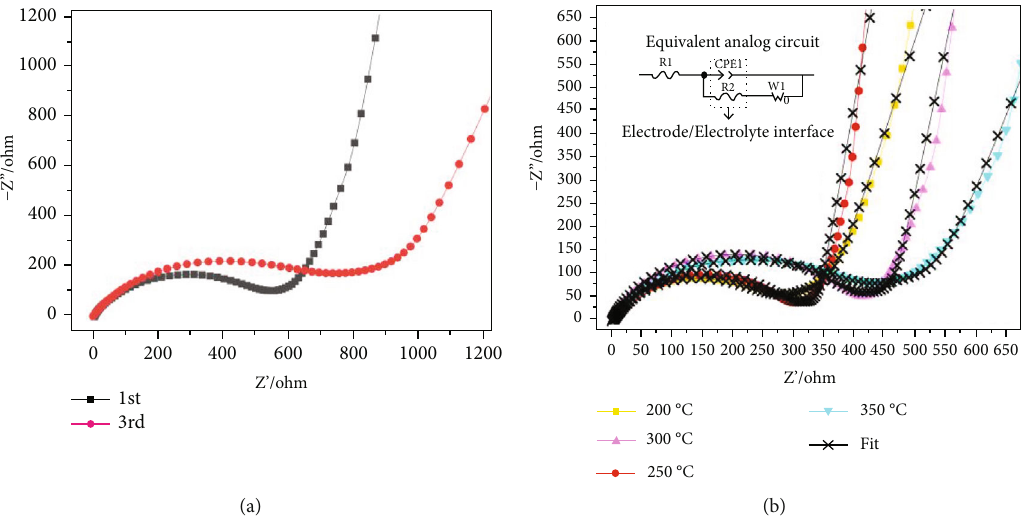
Figure 5: (a) EIS of Zn. (b) EIS and the corresponding equivalent analogue circuits of the ZnS materials at di ff erent sulfurization temperatures.